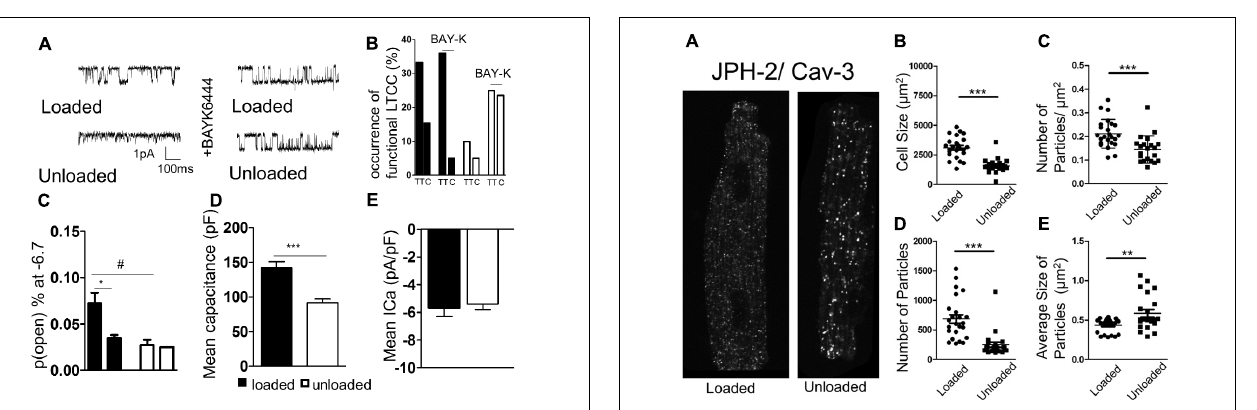
FIGURE 4 | (A) PLA image demonstrating the association of JPH-2 and Cav-3 in loaded and unloaded cells. (B) Graph comparing the size of loaded and unloaded cells (loaded 3104 ± 186.1 µ m 2 vs. unloaded 1561 ± 128.9 µ m 2 N,n 3/22-24 mean ± SEM ∗∗∗ p < 0.001). (C) Graph comparing the number of particles/ µ m 2 in loaded and unloaded cells (loaded 0.212 ± 0.012 particles/ µ m 2 vs. 0.145 ± 0.013 particles/ µ m 2 N,n 3/21-24 mean ± SEM ∗∗∗ p < 0.001). (D) Graph comparing the number of particles in loaded and unloaded cells (loaded 685.9 ± 73.33 vs. unloaded 250.3 ± 46.01 N,n 3/21-24 mean ± SEM ∗∗∗ p < 0.001). (E) Graph comparing the average size of particles in loaded and unloaded cells (loaded 0.435 ± 0.019 µ m 2